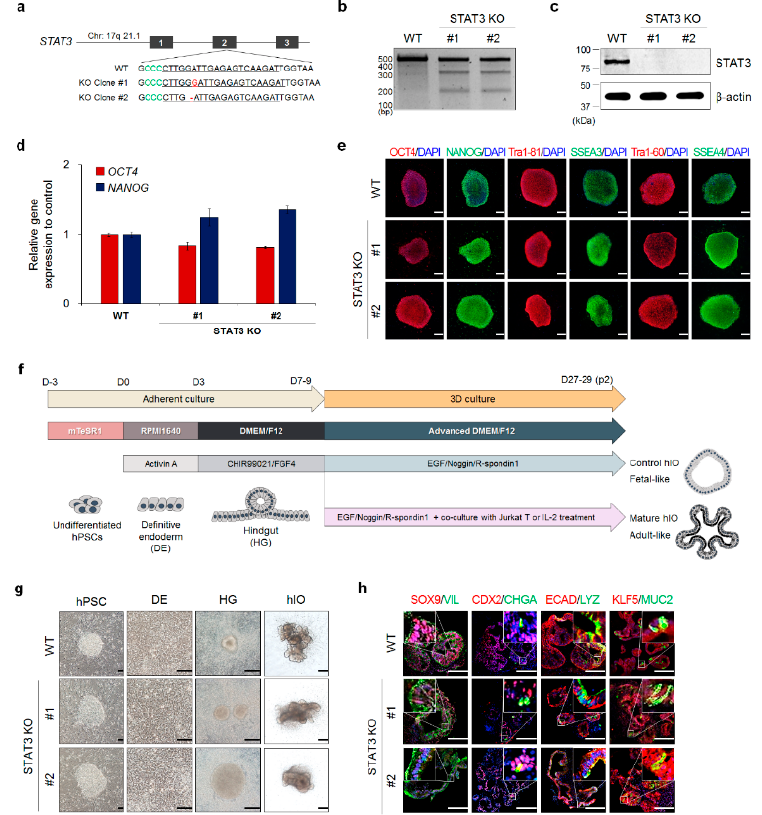
Figure 2. Generation and characterization of the STAT3 KO hESC line using CRISPR-Cas9 genome editing. ( a ) Schematic representation of STAT3 gene structure and the mutant genotype of STAT3 KO hESC lines. Exons of STAT3 are shown by black rectangles, and targeting sequences are indicated at the bottom of the STAT3 gene structure. The nucleotide sequences of sgRNA are underlined, the PAM (NGG) sequences are represented in green letters, and the insertion and deletion mutations in the STAT3 gene are represented by red letters and dashes. ( b ) T7 endonuclease 1 (T7E1) assay for mutation verification of STAT3 KO hESC lines. Genomic PCR products from each clone and heteroduplex of the control and individual clones were digested by T7E1. ( c ) Western blot analysis of STAT3 in WT and STAT3 KO hESC lines. ( d ) qPCR analysis of pluripotency markers in undi ff erentiated H9, WT, and STAT3 KO hESC lines. Data are presented as the mean value of replicates ± SEM. (after two passages of maturation, n = 3 per group). ( e ) Immunofluorescence analysis for the pluripotency markers OCT4, NANOG, TRA-1-60, TRA-1-81, SSEA-3, and SSEA-4. Scale bar, 200 µ